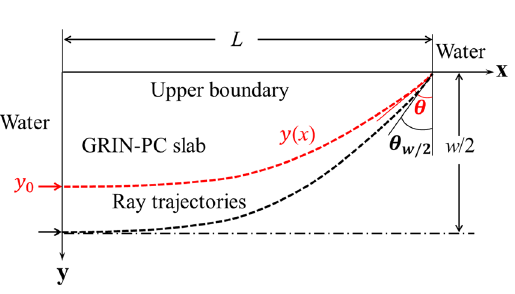
Figure 5. ( a ) The 3D view of the cloaking slab. The circular hole located in the central part is the cloaking area; ( b ) the simulated cloaking result for a circular hole with the diameter of 5.5 a at the frequency of 25 kHz; ( c ) the ratio of the pressure intensity integrals of the two slabs around their cloaking frequencies of 25 kHz and 27 kHz, respectively; and ( d ) comparison between the normalized pressure intensity vs y for the input source position, the 25 kHz cloaking slab output, the 27 kHz cloaking slab output and the uncloaked output wave fields.